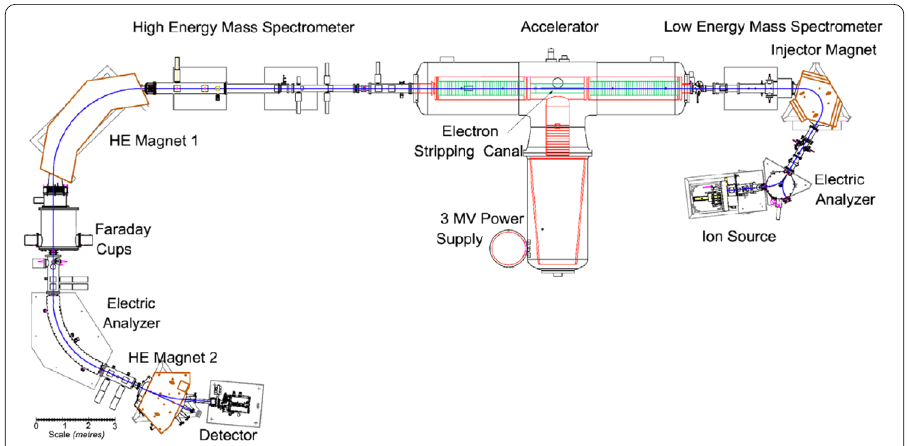
Figure 2 The AMS system at the Lalonde AMS Lab, University of Ottawa. Due to building constraints, the ion beam direction is from right to